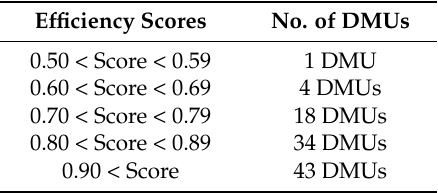
Table 3. Efficiency classification of